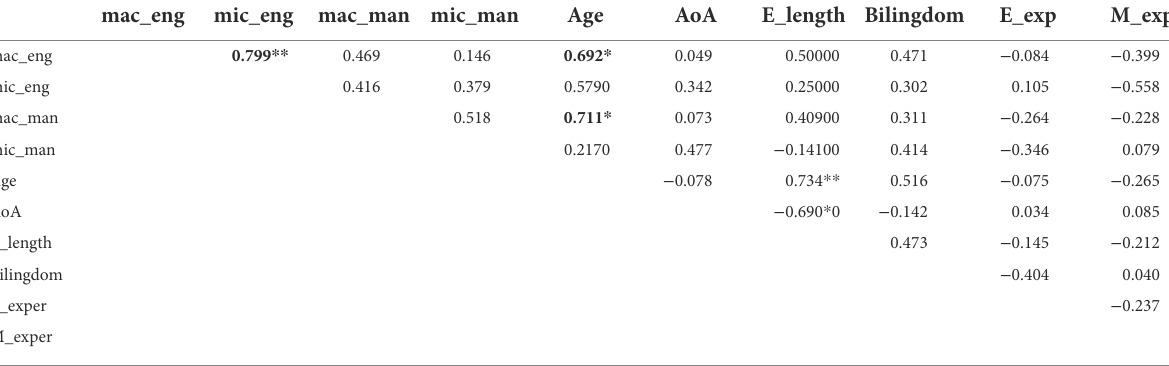
TABLE 5 Correlation matrix of narrative skills with contributing